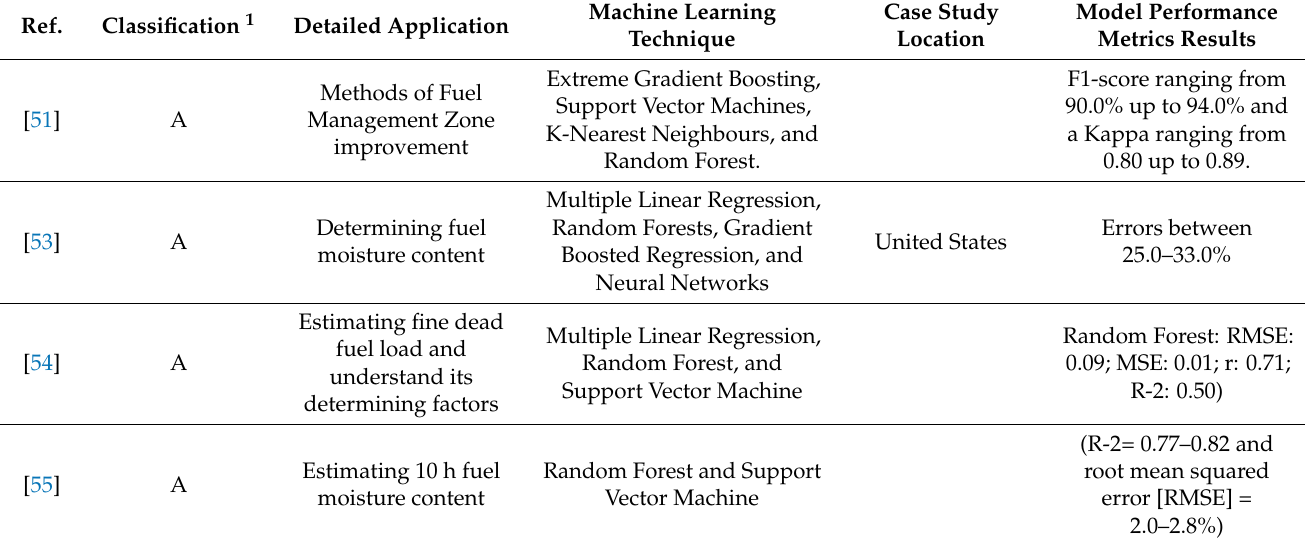
Table 2. Results: pre-fire prevention